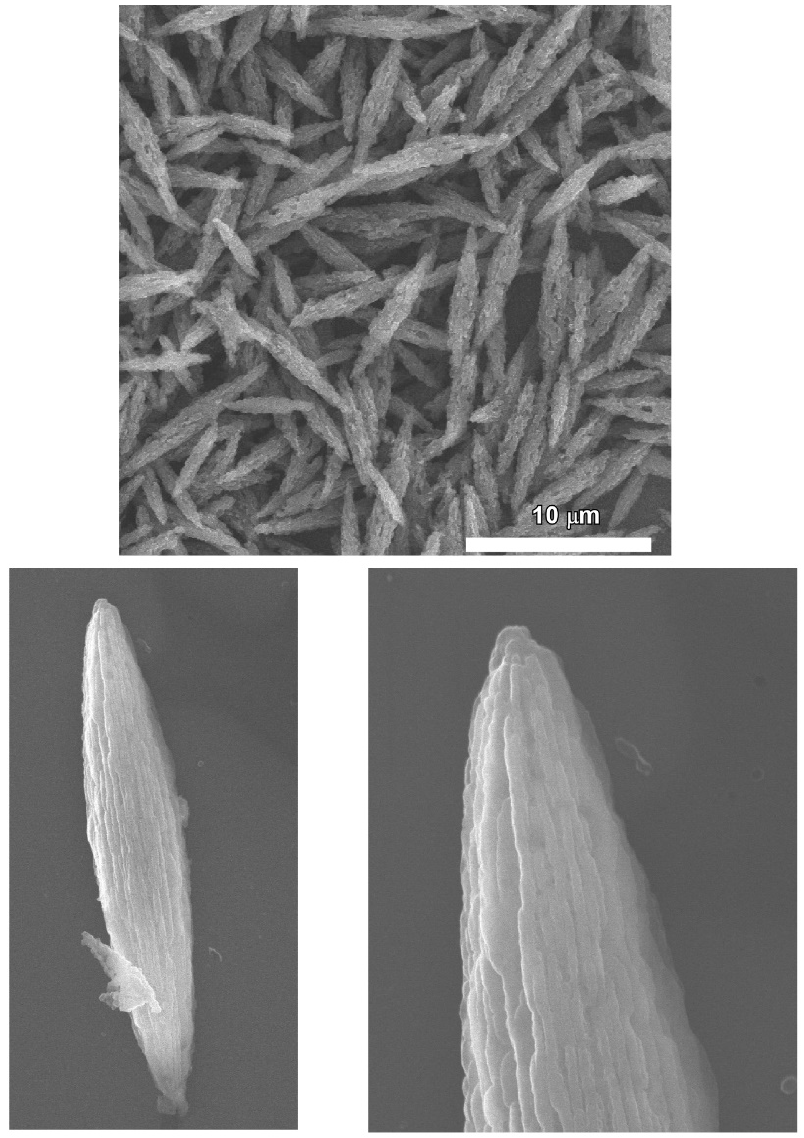
Figure 5. “Bitter melon” shaped nanoporous C 60 assemblies prepared through the liquid–liquid interfacial precipitation method at room temperature [138].